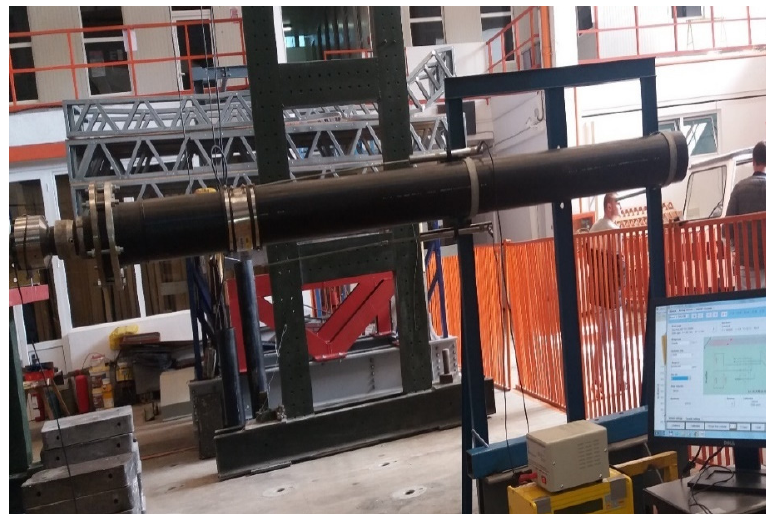
Figure 2. System Consisting of Two Pipeline Sections Joined by Flexseal SC250.